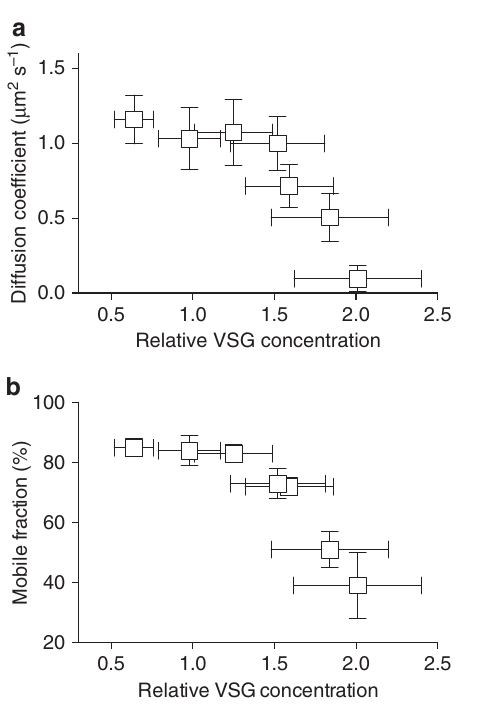
Figure 1 | The VSG coat operates close to its MCT. The impact of lateral protein density on the diffusion of VSG was quantified in supported membranes. Diffusion coefficients ( a ) and mobile fractions ( b ) are displayed as a function of the VSG concentration in relation to the concentration on the trypanosome cell surface. A relative concentration of 1 corresponds to the concentration in vivo. The error bars in y (diffusion coefficient) represent the standard deviation of the mean, while the error bars in x (relative VSG concentration) depict the range.